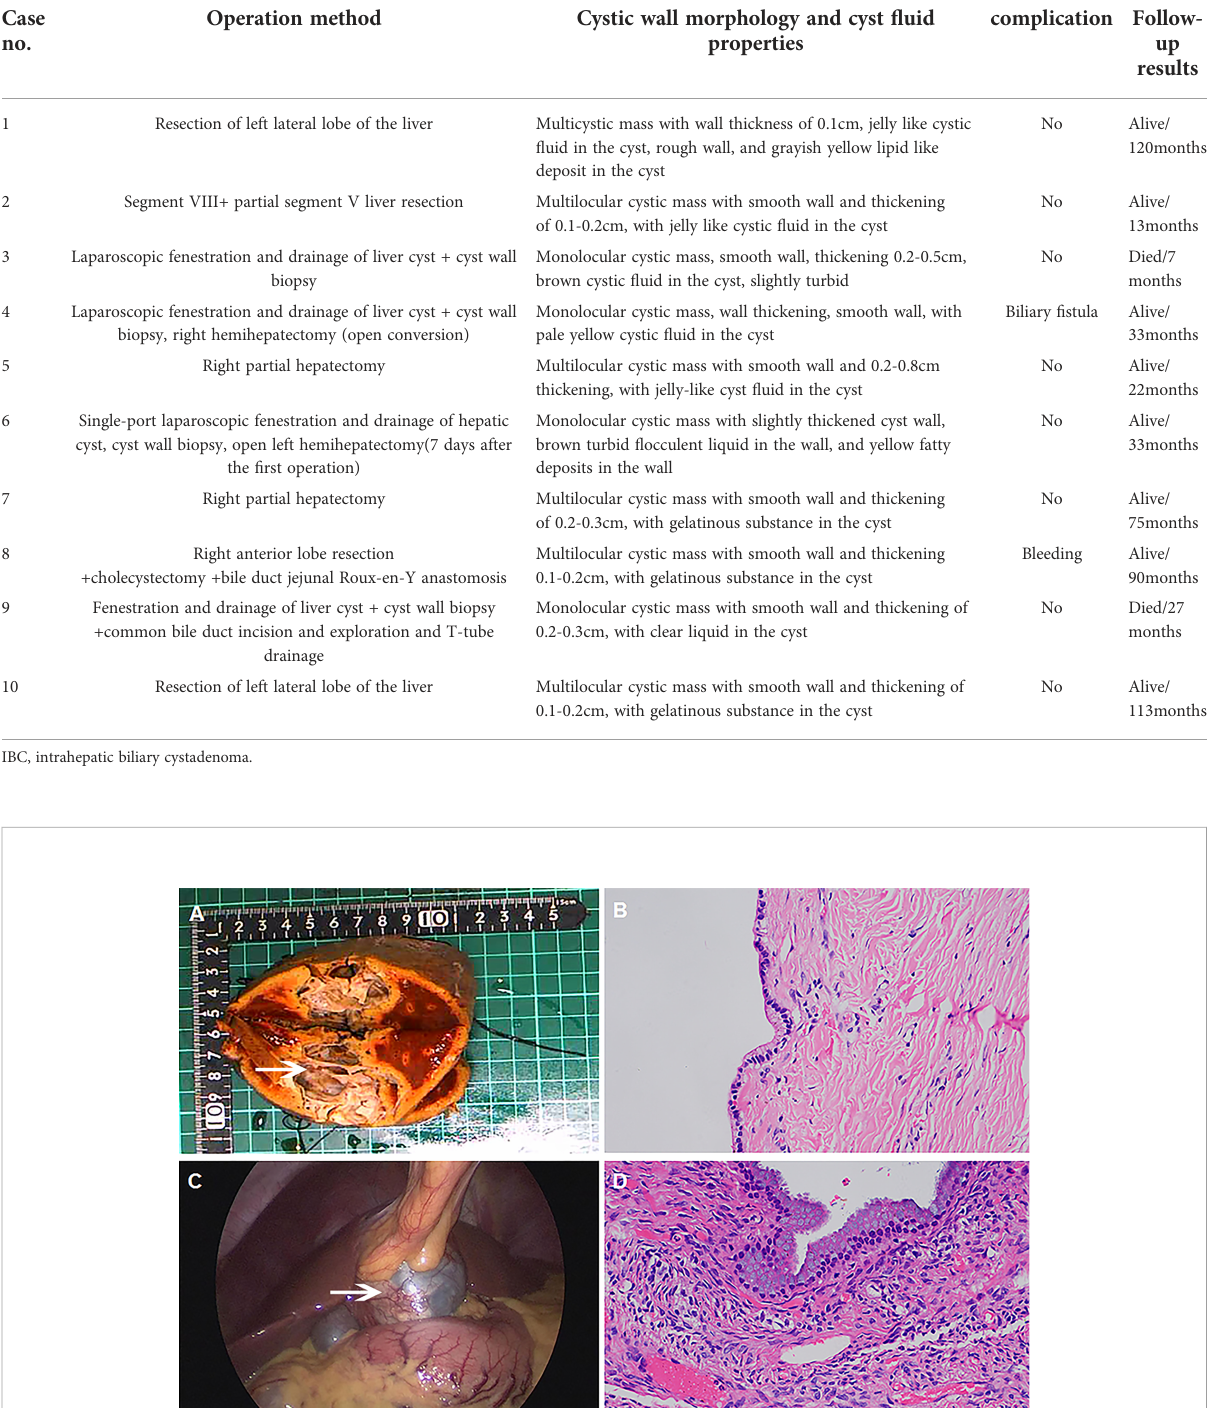
FIGURE 2 Intraoperative fi ndings, postoperative specimens and pathology. ( A Case 2) The resected specimen showed multilocular cystic structure (white arrow), with a wall thickness of 0.1-0.2cm and smooth inner wall. ( B Case 2) Under the microscope, the inner wall of the cyst was covered with a single layer of cuboidal/columnar epithelium, with eosinophilic cytoplasm and nucleus at the base (HE 400 ×). ( C Case 6) Laparoscopic exploration revealed yellow fat-like deposits in the cyst wall (white arrow), and turbid brown cyst fl uid. ( D Case6) Under the microscope, the cyst wall was composed of fi brous tissue, covered with monolayer or columnar, cuboidal epithelium, and ovarian-like stroma was seen locally (HE 400 ×).